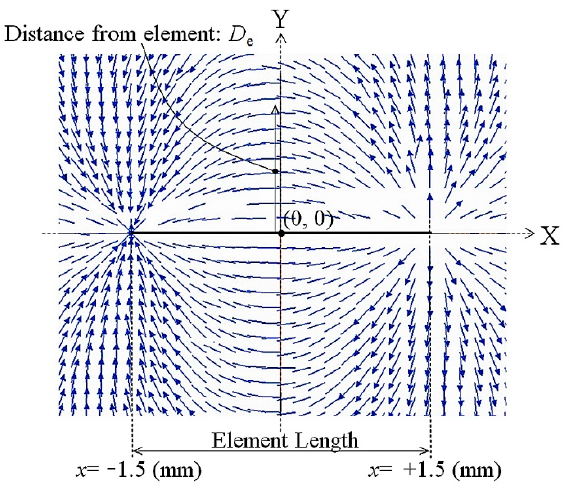
Figure 17. Vector diagram of the magnetic flux density arising from one narrow strip element.